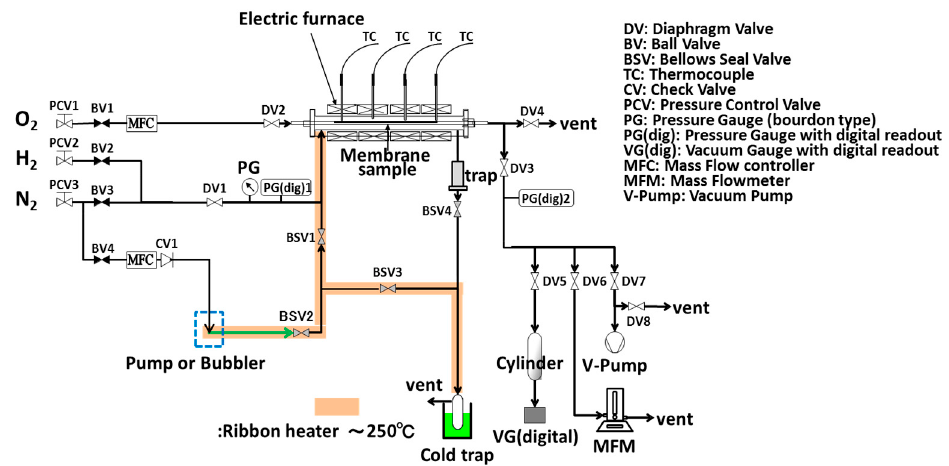
Figure 4. A schematic diagram of chemical vapor deposition (CVD) and the permeation evaluation